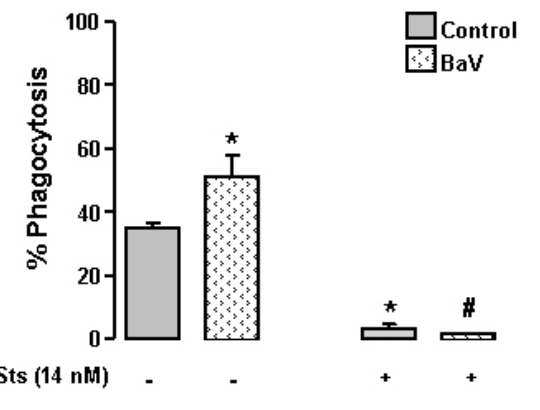
Figure 4. Effect of PKC inhibition on BaV-induced phagocytosis of opsonized zymosan particles. Thioglycollate-elicited macrophages were incubated with BaV (6 μg/mL) or RPMI (control) in the presence or absence of staurosporine (Sts – 14 nM/mL, 15 minutes) followed by the addition of opsonized zymosan particles. Phagocytosis was evaluated by phase-contrast microscopy. Values are mean ± SEM from four animals. * p < 0.05 compared to controls; # p < 0.05 compared to BaV without staurosporine (ANOVA).